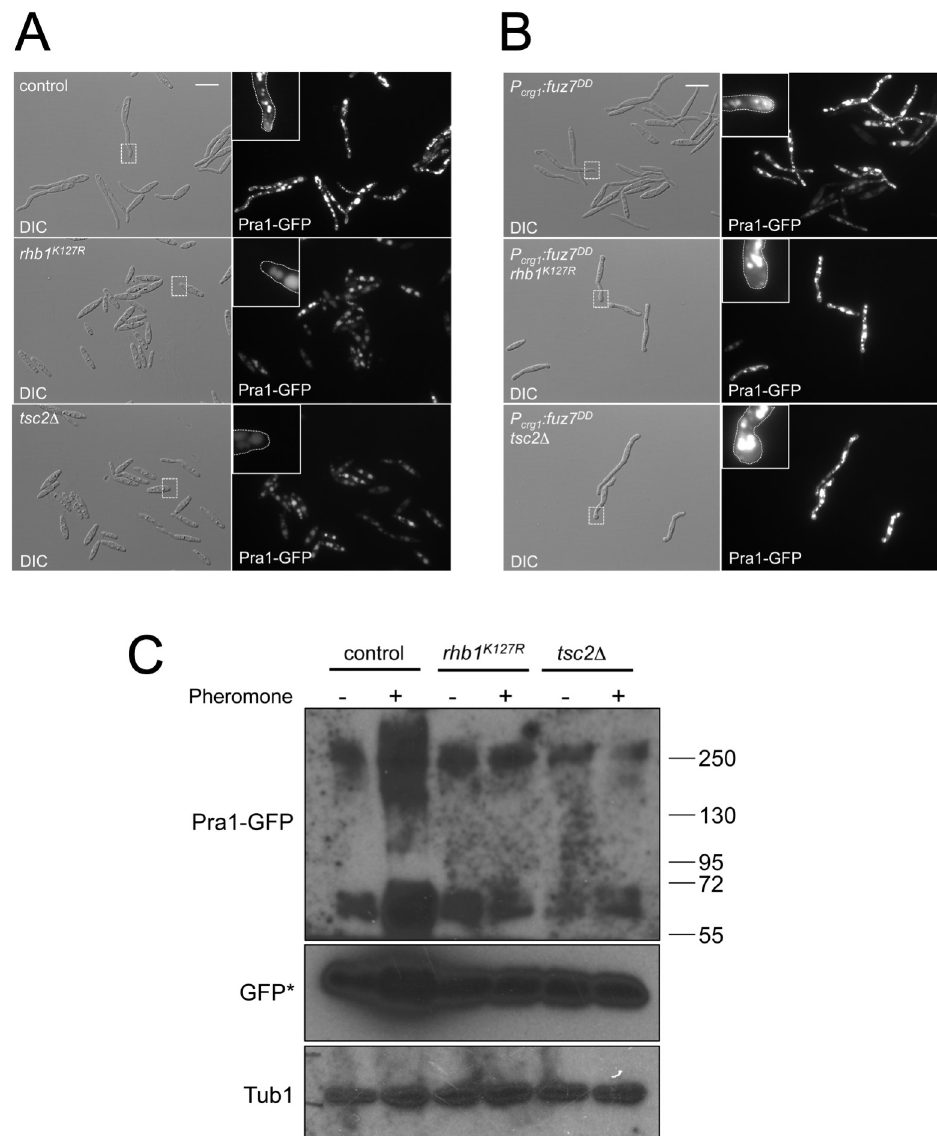
Fig 8. Forced activation of Rheb resulted in mislocalization of the pheromone receptor. (A) Pra1-GFP is not polarized in the strains carrying the Rheb-activating mutations. Fluorescent cell images from cultures of the indicated strains carrying an endogenous pra1-GFP allele incubated for 6 hours in minimal ammonium media in the presence of synthetic a2 pheromone (2.5 μ g/ml). Cell images were obtained with the same time exposure. Insets showed magnification of selected cell tips (indicated in DIC images as dashed rectangles). Bar: 15 μ m. (B) Pra1-GFP is not polarized in the Rheb-activating mutant strains, even in the presence of conjugation tubes. Fluorescent cell images from cultures of the indicated strains carrying an endogenous pra1-GFP allele and an ectopic copy of P transgene incubated for 6 hours in minimal ammonium media amended with arabinose to induce the expression of the activated MAPKK. Insets showed magnification of selected cell tips (indicated in DIC images as dashed rectangles). Cell images were obtained with the same time exposure. Bar: 15 μ m. (C) Pra1-GFP fusion is present in conditions of forced Rheb activation. Western blot analysis of cell extracts from indicated cultures incubated for 6 hours in minimal ammonium media in the presence or absence of synthetic a2 pheromone (2.5 μ g/ml). The same filter was incubated in succession with anti-GFP and anti-tubulin (as loading control). The filter incubated with anti-GFP was exposed at different times (GFP � exposition was 1/10 from Pra1-GFP exposition). The expected size of Pra1-GFP fusion was 67,63 kD, but a significant fraction migrates at much higher sizes (ca. 250 kD) in all cases.